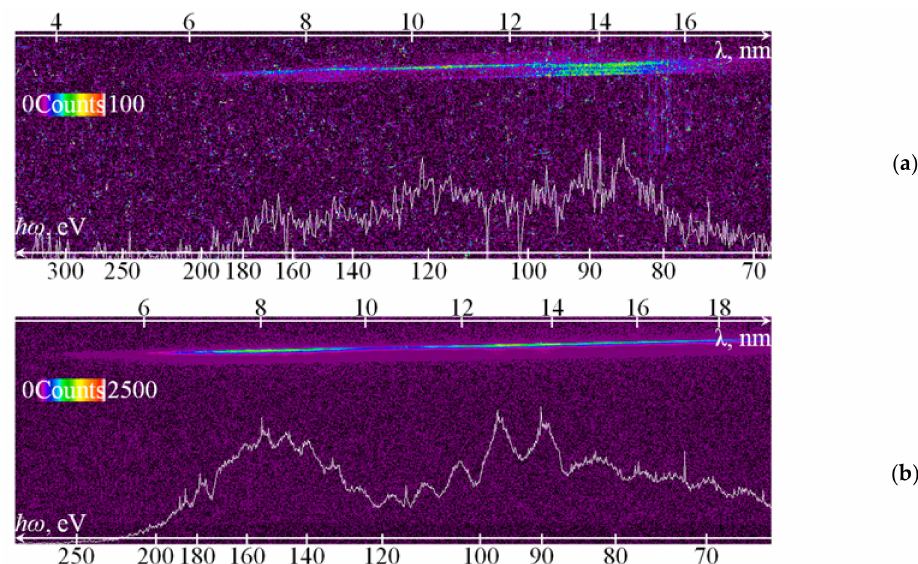
Figure 9. Examples of the raw data. ( a , b ) Data obtained in the experimental campaigns with the focal spots shown in Figure 2a,b, respectively.